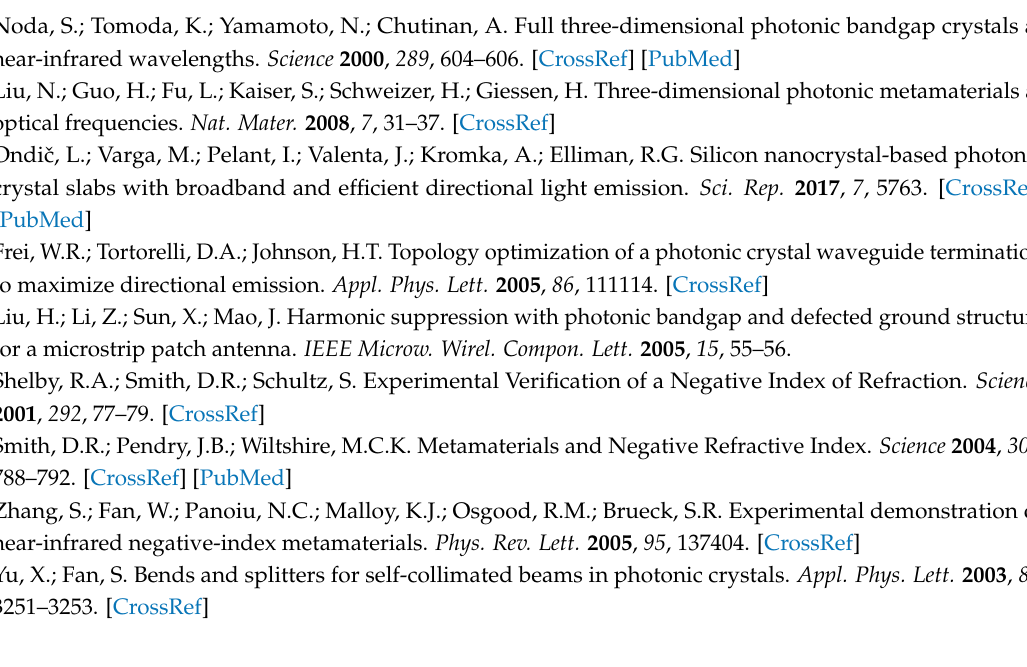
s1, Figure S1: SEM images of silica microspheres, (a) 105 nm, (b) 174 nm, (c) 201 nm, (d) 201 nm, (e) 212 nm, (f) 228 nm, (g) 283 nm, (h) 305 nm, (i) 403 nm, Figure S2: SEM images of silica microspheres (a) 66 nm, (b) 78 nm, Figure S3: Zeta potential changes of silica microspheres before and after surface chemical modification. (a) Zeta potential of silica microspheres, (b) Zeta potential of aminated silica microspheres, (c) Zeta potential of silica microspheres after carbonylation, Table S1: Concentration ratios of ammonia, TEOS, and deionized water, Table S2: Statistical analysis of synthesized silica microspheres, Table S3: Accuracy analysis of fitting regression